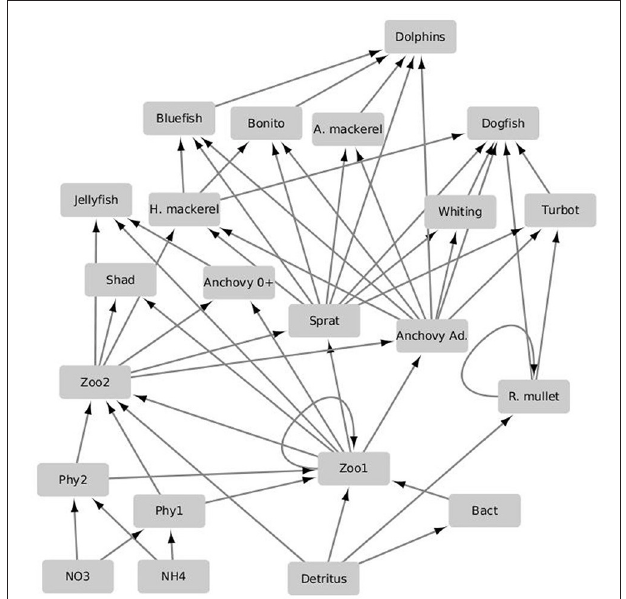
FIGURE 2 | Schematic of the lower trophic level integrated higher trophic level model EwE used in the study. The planktonic and non-living model compartments as well as their related flows and uptakes are referenced to and parameterized according to the biogeochemical model. The arrows denote directions of predatory and uptake flows. Functional groups are abbreviated as follows: Atlantic mackerel (A. mackerel); adult anchovy (Anchovy ad.); larval anchovy (Anchovy 0 + ); red mullet (R. mullet); horse mackerel (H. mackerel); microzooplankton (zoo1); mesozooplankton (zoo2); dinoflagellates, diatoms and coccolithophores (phy1); nanophytoplankton (phy2); bacteria (Bact), nitrate (NO 3 ); ammonium (NH 4